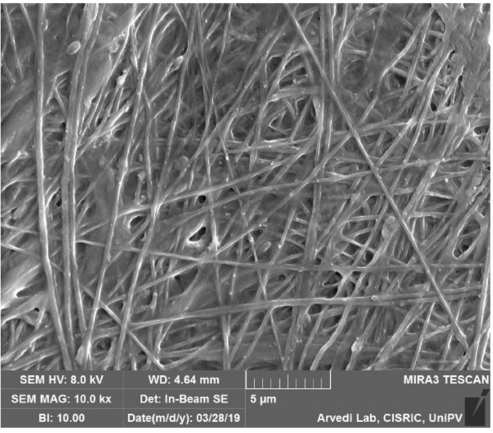
Figure 2. SEM micrograph of G4 nanofibers after cross-linking